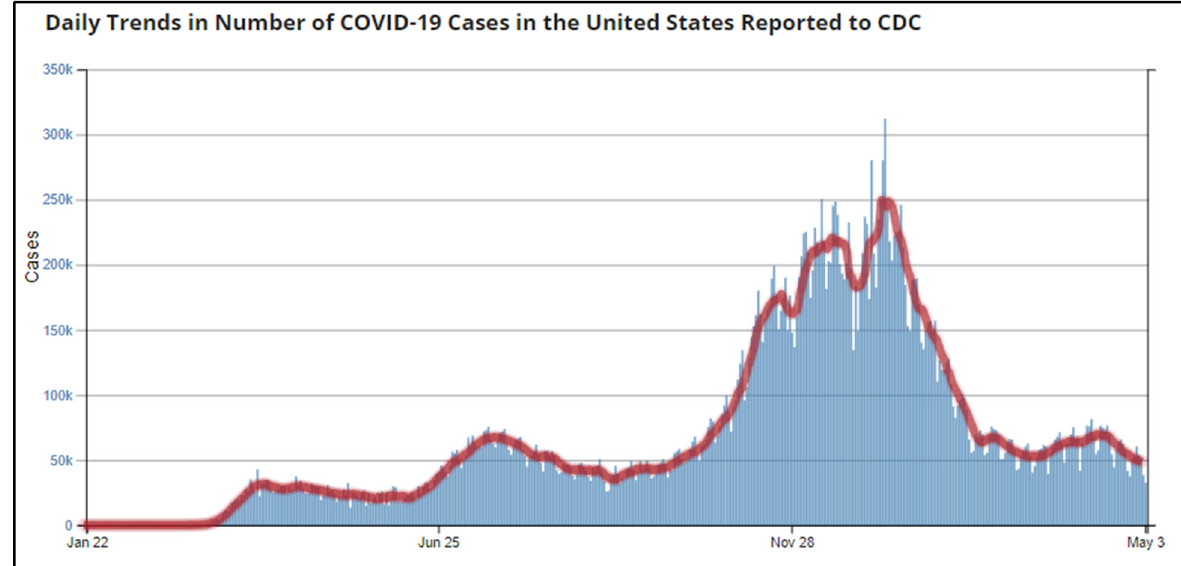
Figure 2. Daily Trends in Number of COVID-19 Cases in the United States Reported to Center for Disease Prevention and Control (CDC) (Source: Reproduced from the CDC) [4].